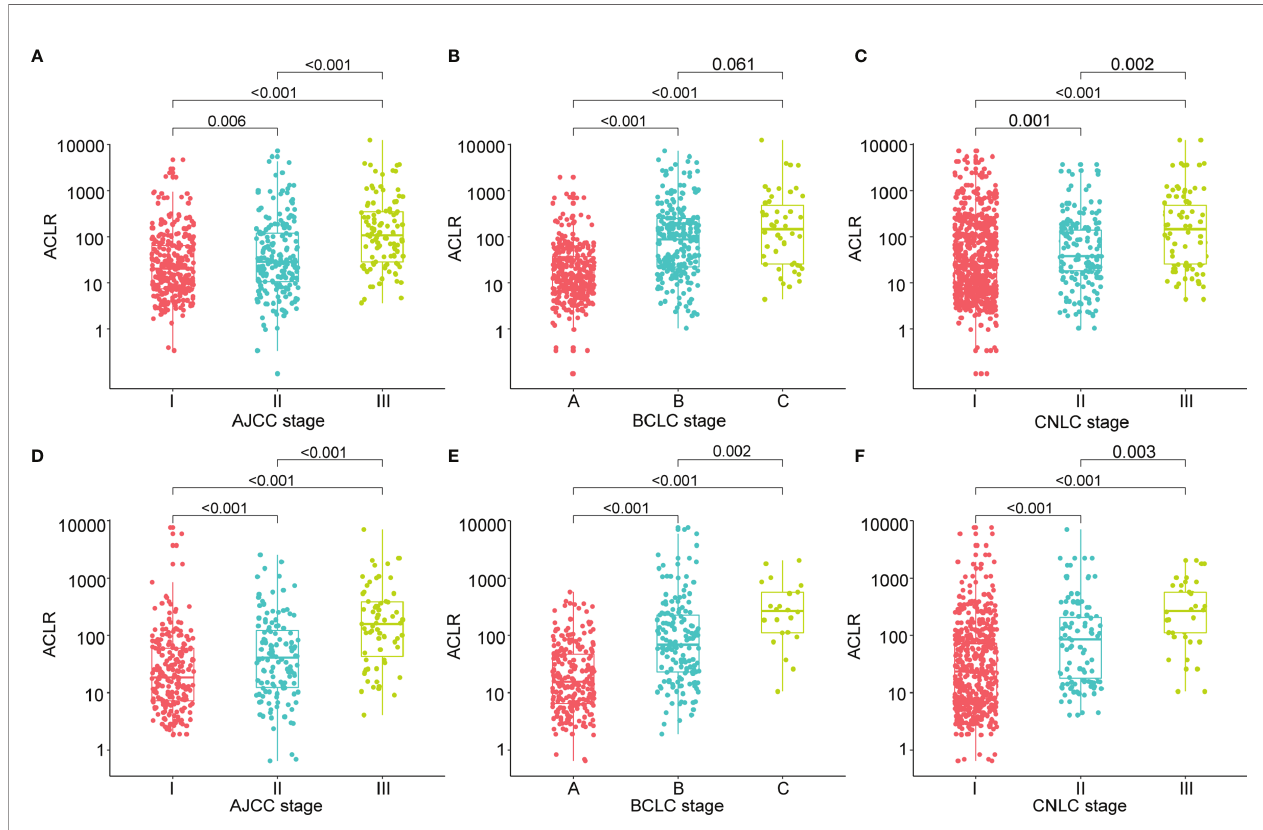
FIGURE 1 | Clinical signi fi cance of ACLR in patients with HCC from the training cohort and validation cohort. (A – C) Scattergrams of ACLR according to (A) AJCC stage, (B) BCLC stage, and (C) CNLC stage in patients with HCC from the training cohort. (D – F) Scattergrams of ACLR according to (D) AJCC stage, (E) BCLC stage, and (F) CNLC stage in patients with HCC from the validation